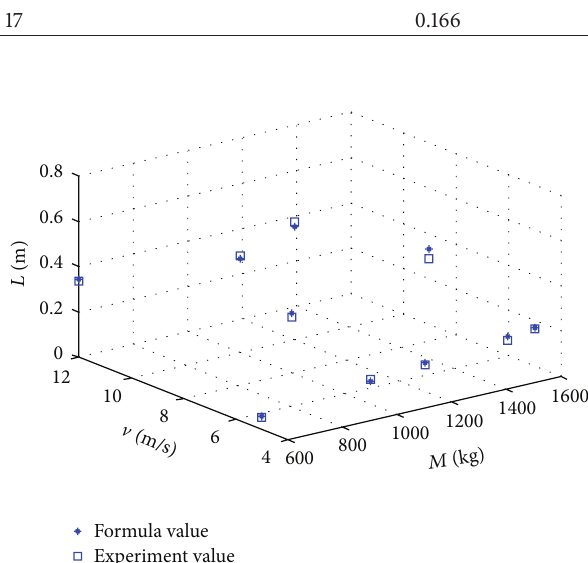
Figure 11: Experiment data of Tramcar braking distance.